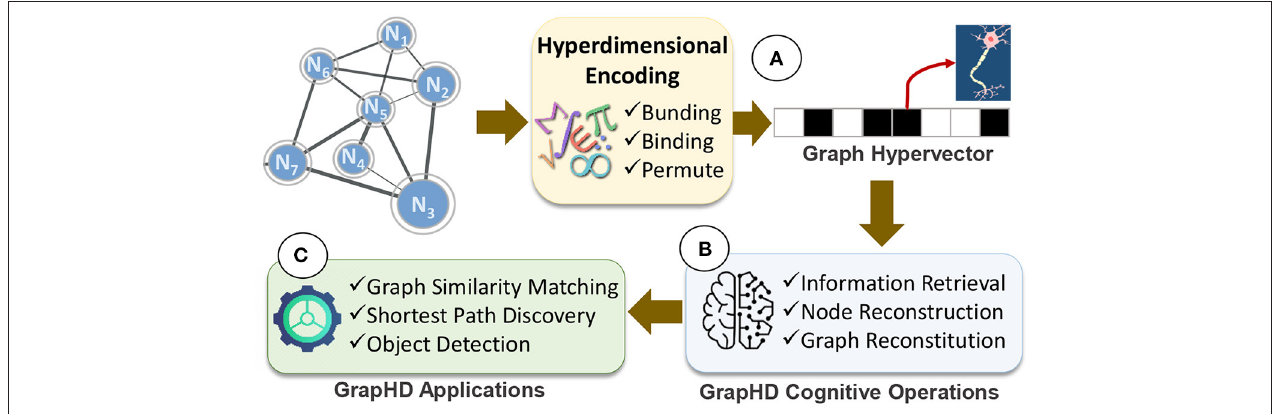
FIGURE 1 | GrapHD overview: (A) hyperdimensional graph encoding into a hypervector, (B) GrapHD cognitive operations, and (C) GrapHD